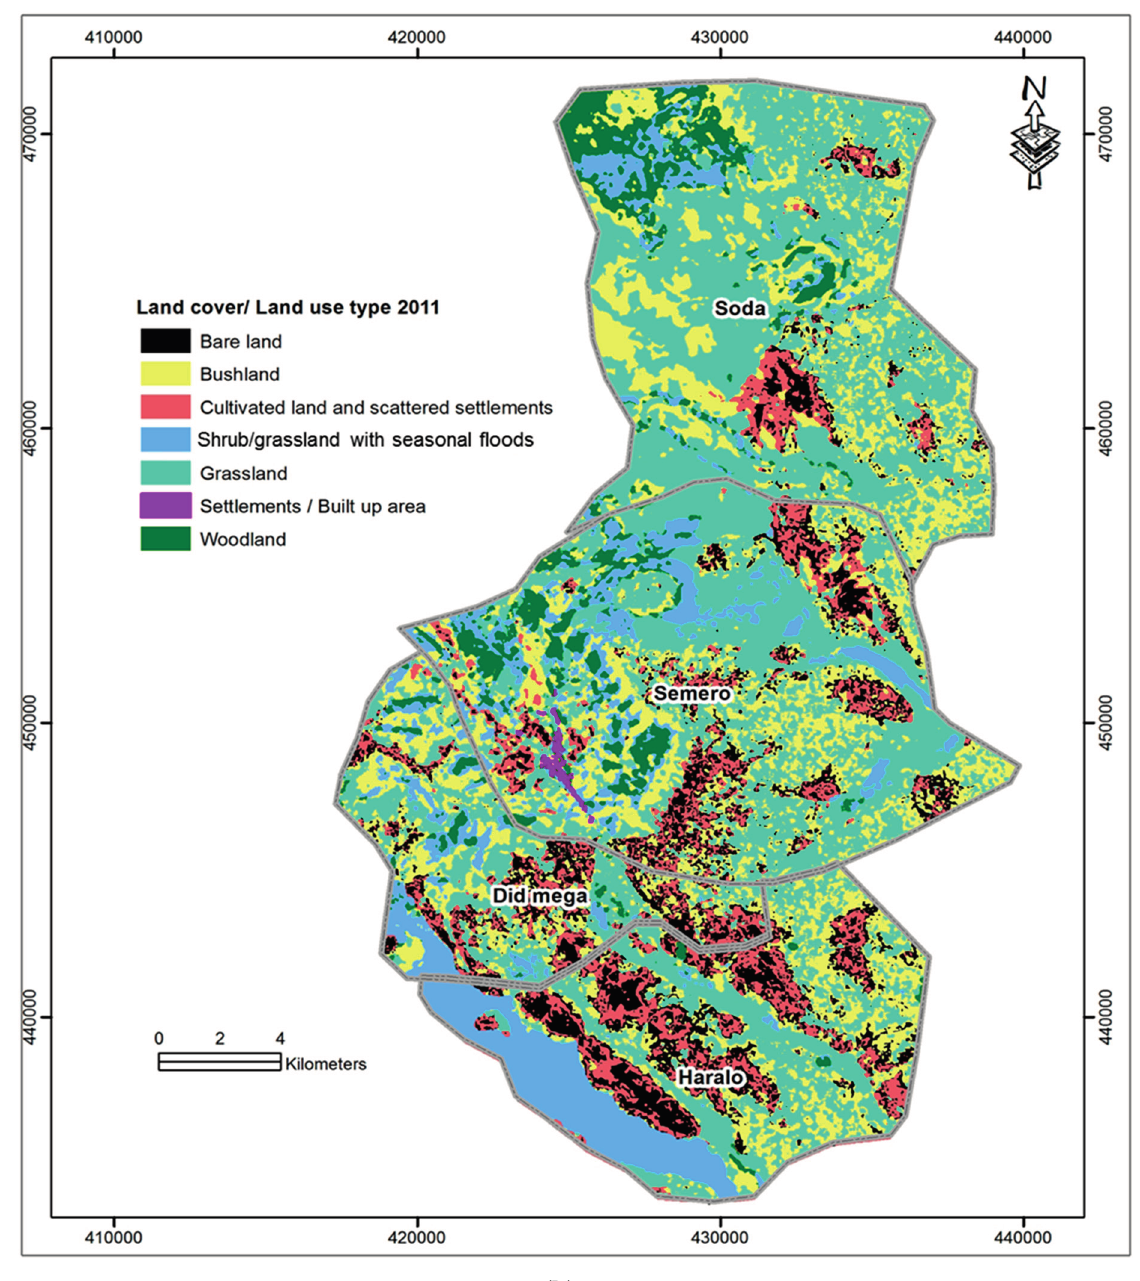
Figure 3. Land cover classes and land cover changes of four sites in Mega between 1985 ( a ) and 2011 ( b